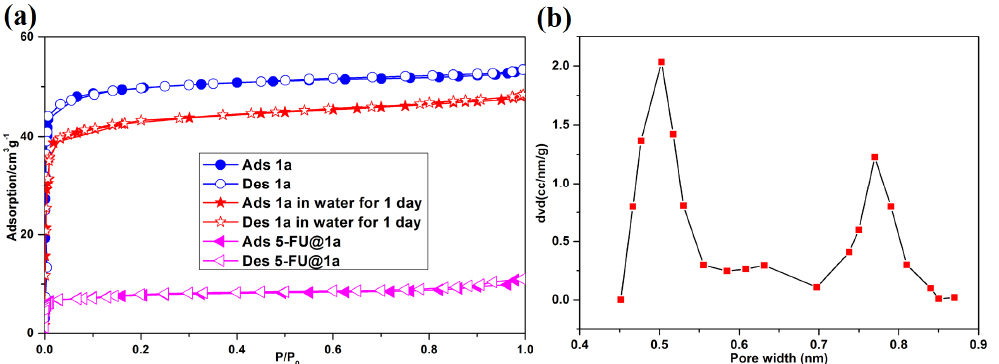
Figure 6. ( a ) N 2 adsorption-desorption isotherms of activated 1a , 1a after in water for one day, and 5-FU-@ 1a at 77 K. ( b ) Pore size distribution o f complex 1a based on the NLDFT